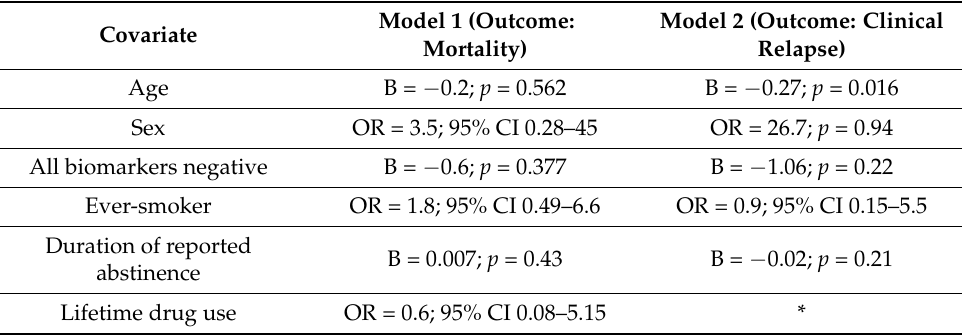
Table 2. Cox-regression